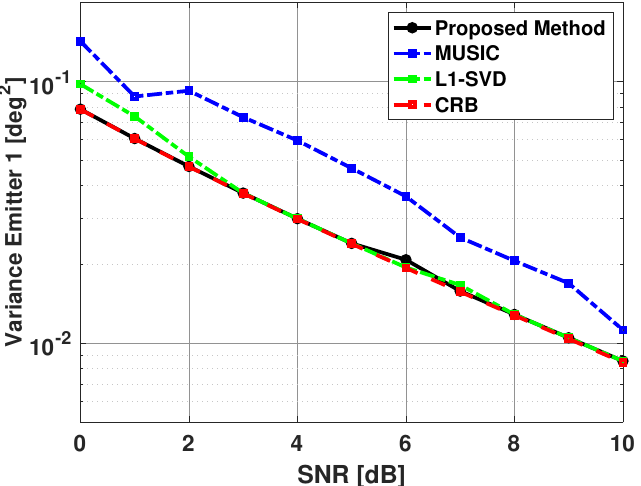
Figure 13. Variance in the estimated direction of the first emitter versus SNR: Proposed Method, MUSIC Algorithm, and L1-SVD Algorithm, Emitters at 60 and 63 deg, 100 snapshots, 500